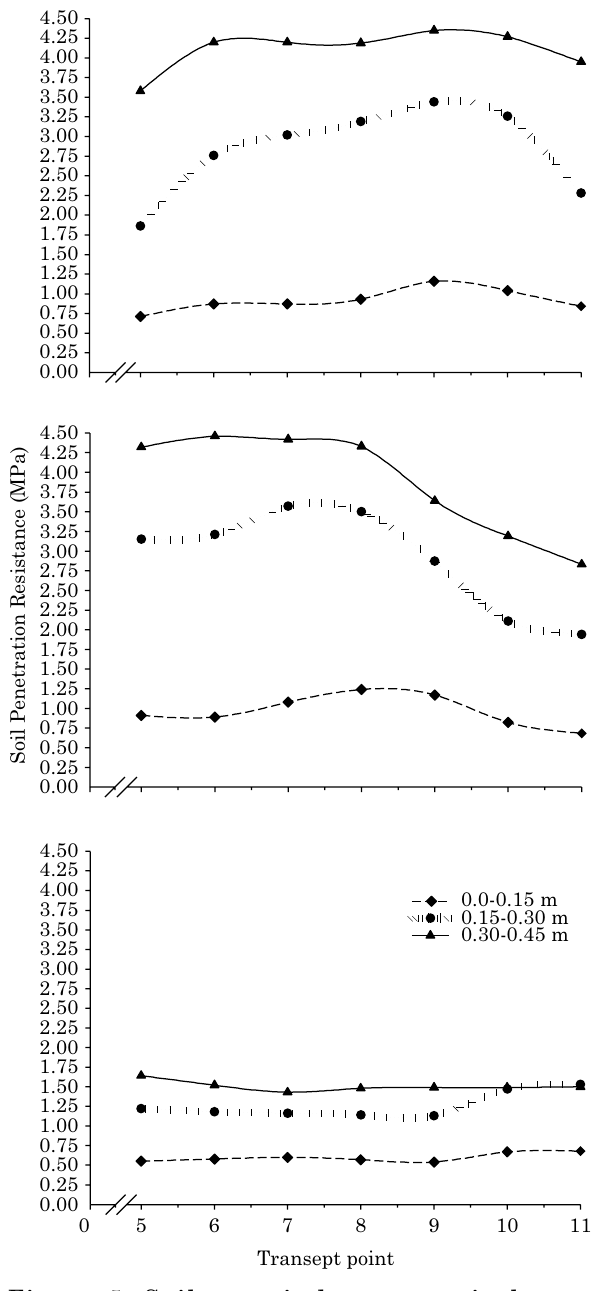
figure 5. Soil cone index curves in layers (0.00-0.15, 0.15-0.30 and 0.30-0.45 m), under conventional tillage (a), in-row deep tillage with traffic (b), and in-row deep tillage without traffic (c), in 2013.